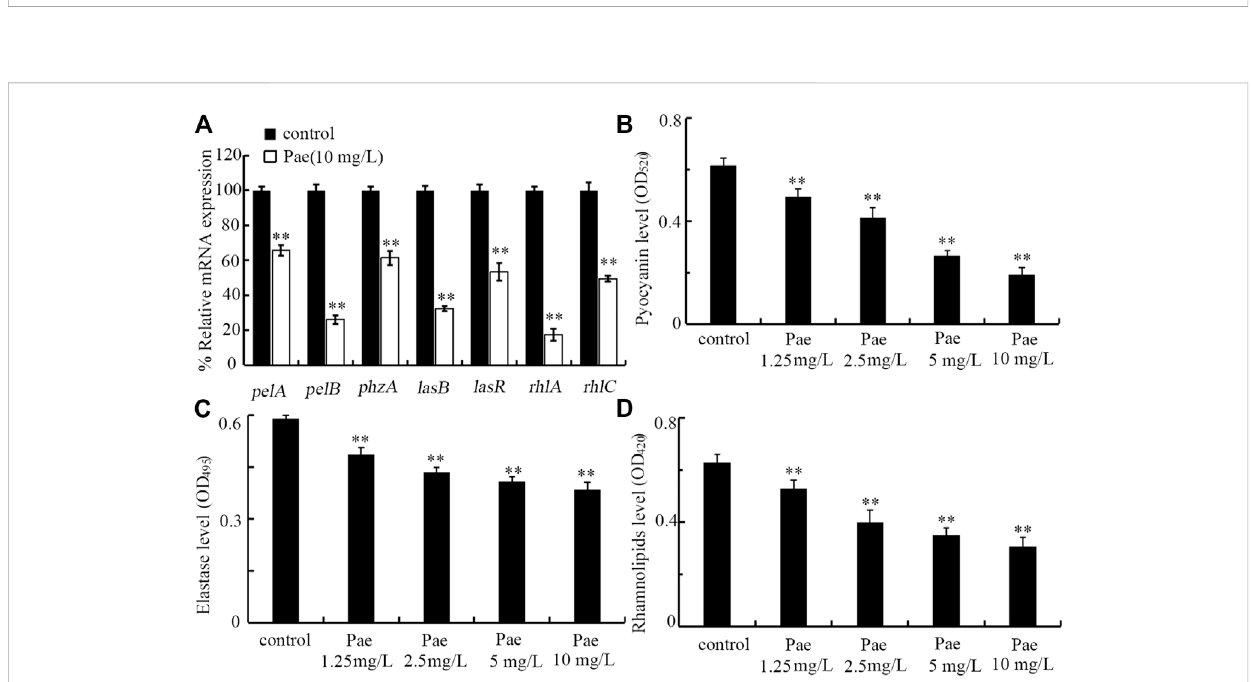
Effectofpaeoni fl orintreatmentonexpressionsofvirulencegenesandvirulencefactorsofpyocyanin,elastase,andrhamnolipid. (A) Effectof10 mg/ L paeoni fl orin treatment on expressions of virulence genes required for P. aeruginosa bio fi lm formation. (B – D) Effect of paeoni fl orin treatment on levels of pyocyanin, elastase, and rhamnolipid. Pae, paeoni fl orin. ** p < 0.01 vs .